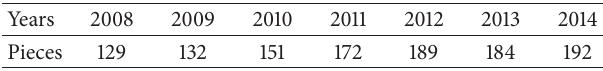
Table 1: Statistics of conflict events from 2008 to 2014 in China.